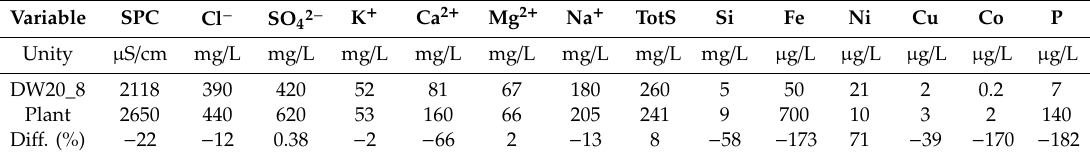
Table 3. Comparison of composition between the final water from the dissolution with DW at 20 ◦ C (DW20_8) and the average value recorded on-site. The di ff erence is shown in percentage.